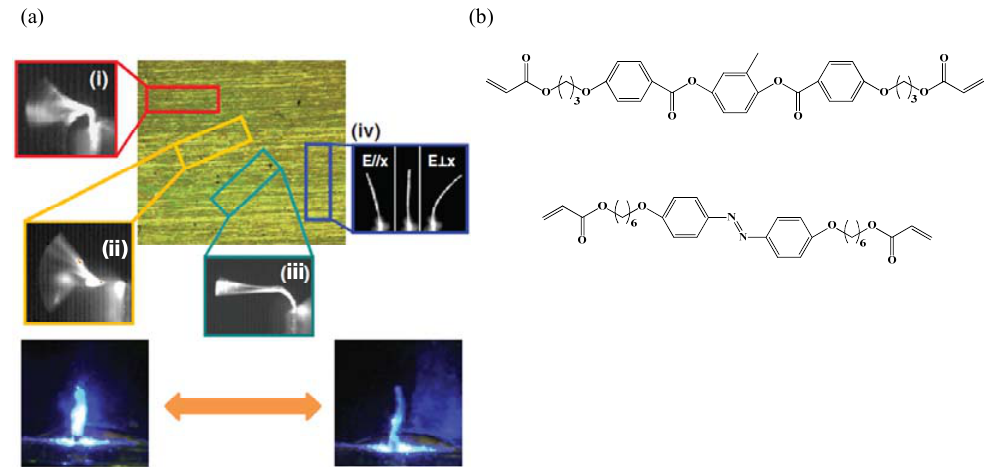
Figure 15. ( a ) Polarization optical micrograph of azobenzene containing LCN and photomechanical response of LCN films with nematic director cut at (i) 0°, (ii) 15°, (iii) 45°, (iv) 90° to the long axis of the LCN film. ( b ) Chemical structure of molecules used for the synthesis of photo-responsive LCN cantilevers. Reprinted with permission [78]. Copyright Wiley-VCH 2011.